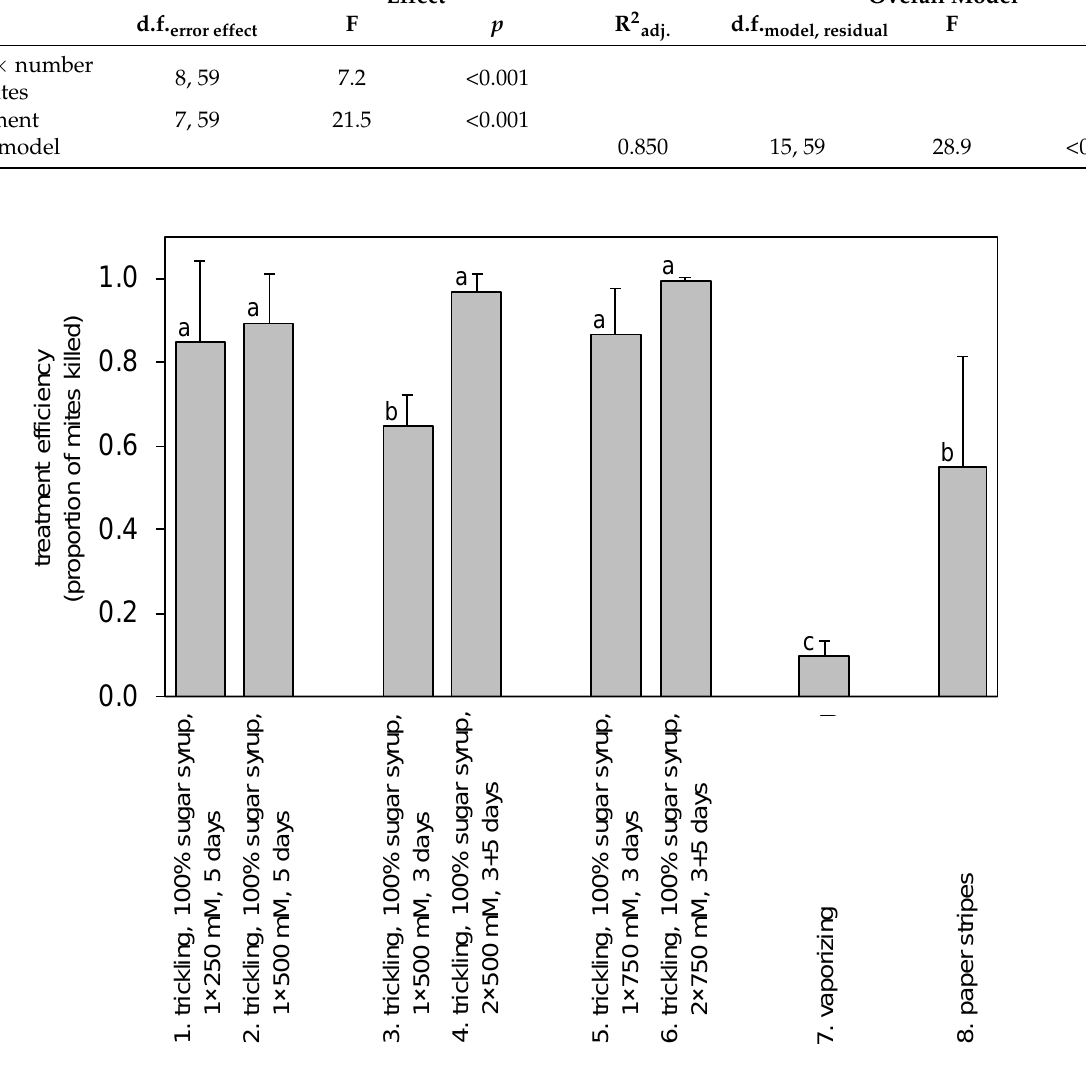
Table 3. General linear model analysis considering the influence of the number of mites (covariate) on treatment efficiency via the separate-slopes design revealed significant variation in efficiency across eight tested anti- Varroa LiCl treatment types. Results of Tukey HSD post hoc tests are shown in Figure 1.